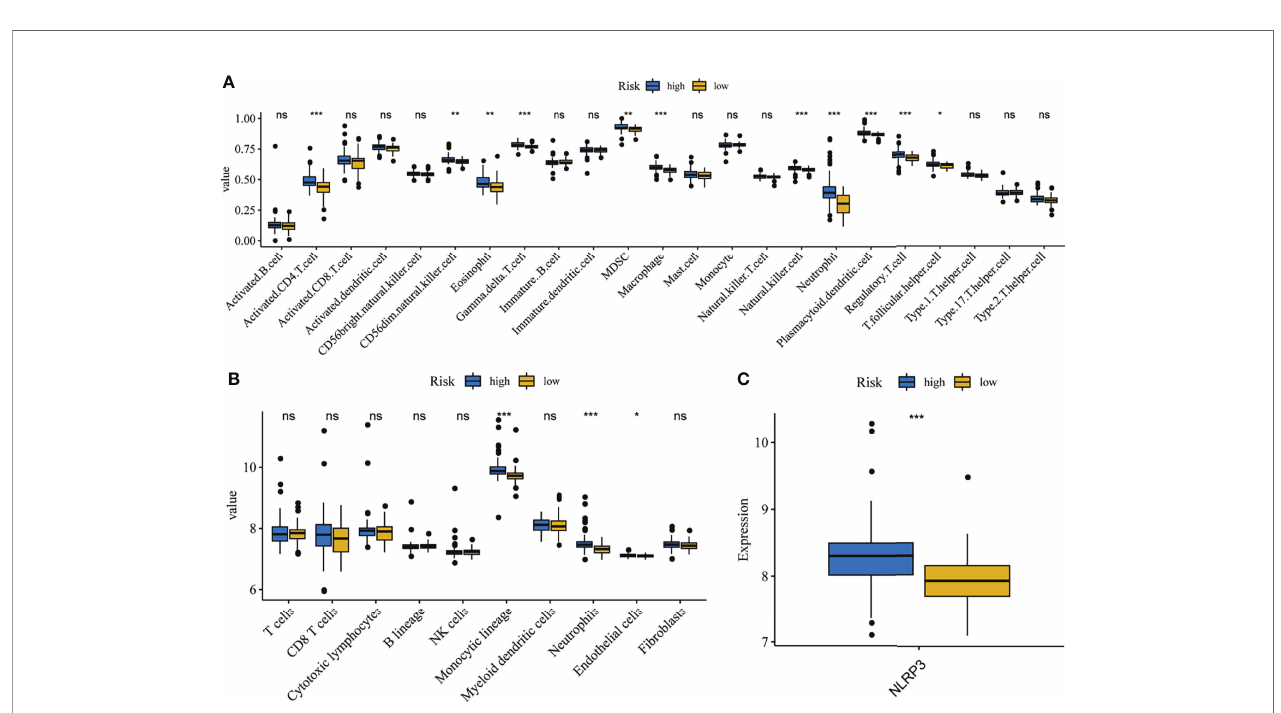
FIGURE 8 | Correlation analysis of immune and in fl ammation. Differentially composition of in fi ltrated immune cells between high- and low-risk group via ssGSEA (A) and MCP counter (B) analysis. (C) The expression levels of NLRP3 between high-and low-risk groups. *p < 0.05, **p < 0.01, ***p < 0.001, ns, no signi fi